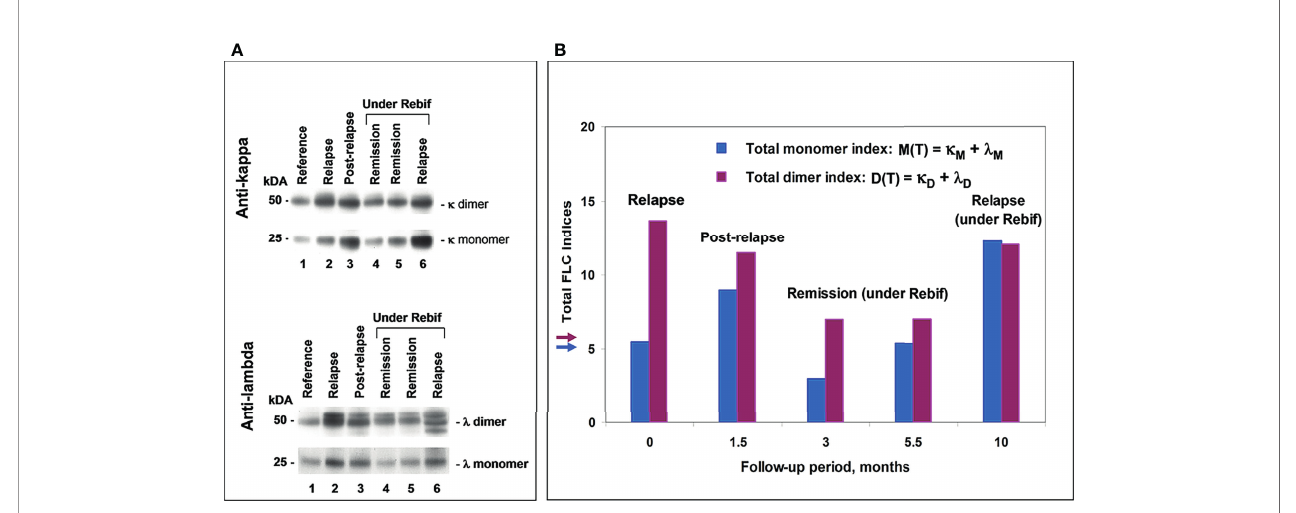
FIGURE 6 | POMS patient #5 follow-up using saliva FLC test. (A) Western blotting of k and l FLC monomers and dimers: track 1 – reference sample; track 2 - patient in relapse (starting point); track 3 - post-relapse, 1.5 months later; tracks 4 and 5 – remission under Rebif, 3 and 5.5 months later, respectfully; track 6 – relapse, 10 months later, with an appearance of new active lesions (under Rebif, before initiation of CS). (B) Chart: vertical axis y shows total FLC monomer and dimer indices, namely, M(T) = ( k M + l M ) – blue, D(T) = ( k D + l D ) – purple; horizontal axis x – follow-up period (months). Arrows indicate the cut-off values of indices to distinguish between normal and abnormally high FLC